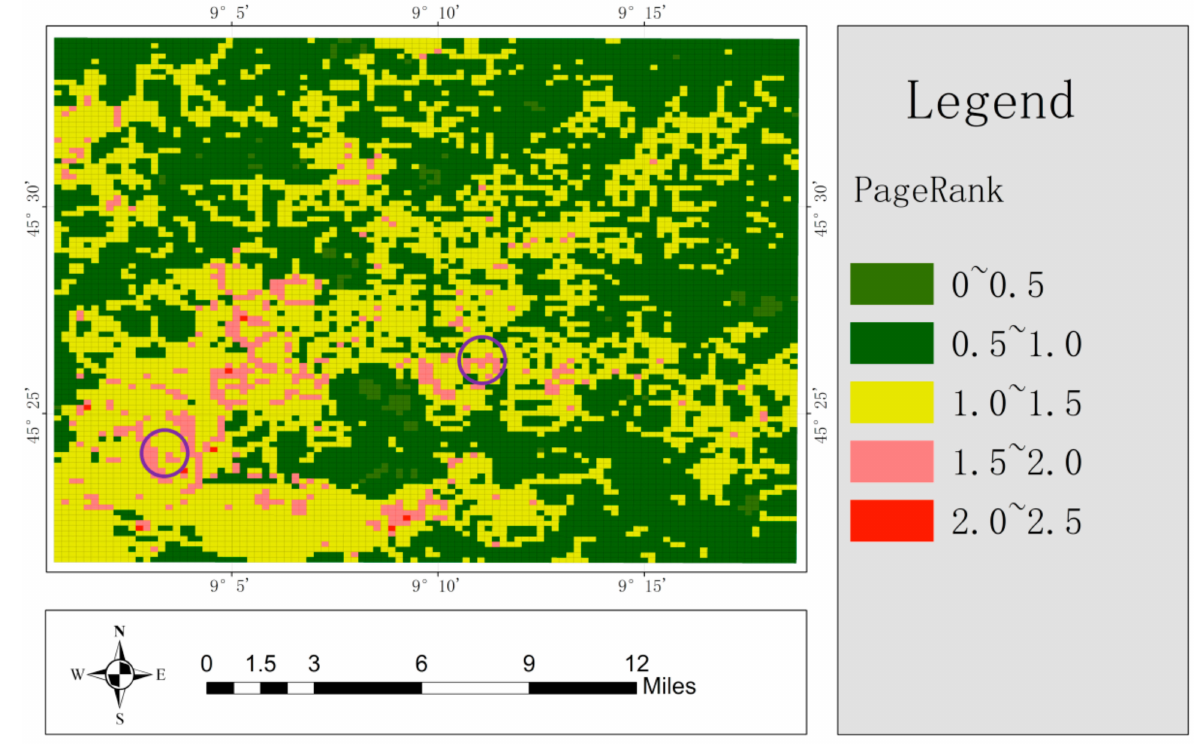
Figure 12. Thematic map of node PageRank values.